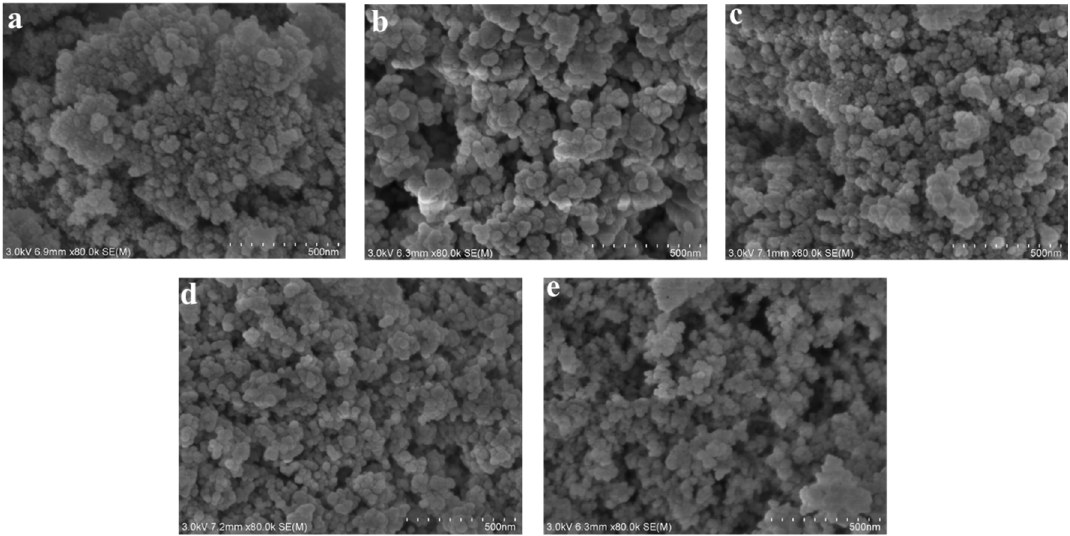
Figure 2. SEM images of ( a ) γ -Al 2 O 3 ; ( b ) MgO; ( c ) TiO 2 ; ( d ) ZrO 2 ; ( e ) SiO 2 .